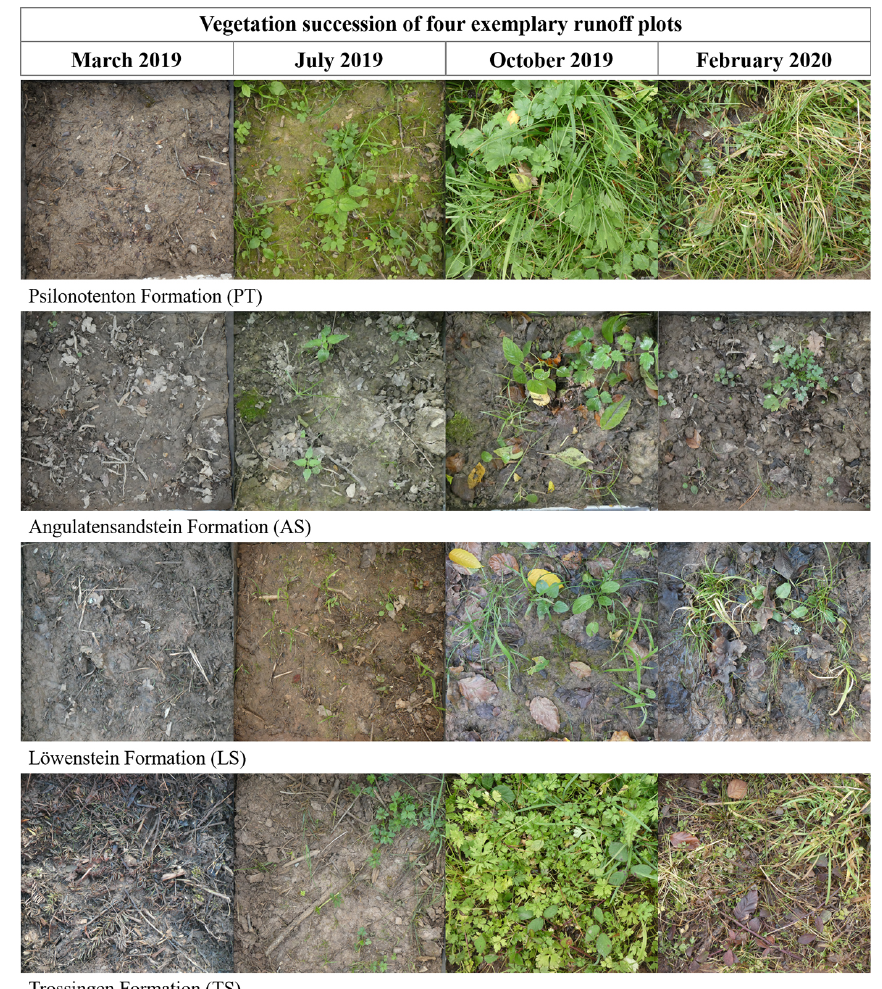
Figure 2. Vegetation succession of four exemplary runoff plots in wheel tracks of the skid trails in Schönbuch Nature